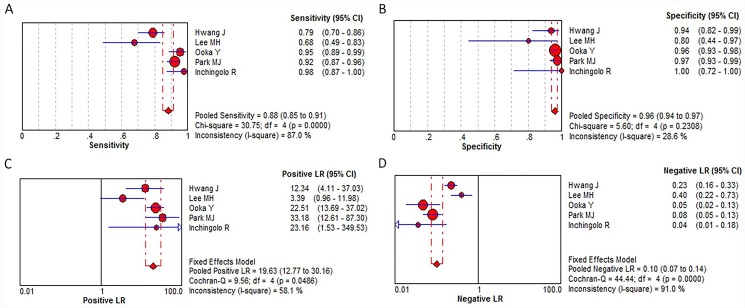
Forest plots of the estimates for combination of Gd-EOB-DTPA-enhanced MRI and DWI sequence in HCC diagnosis.